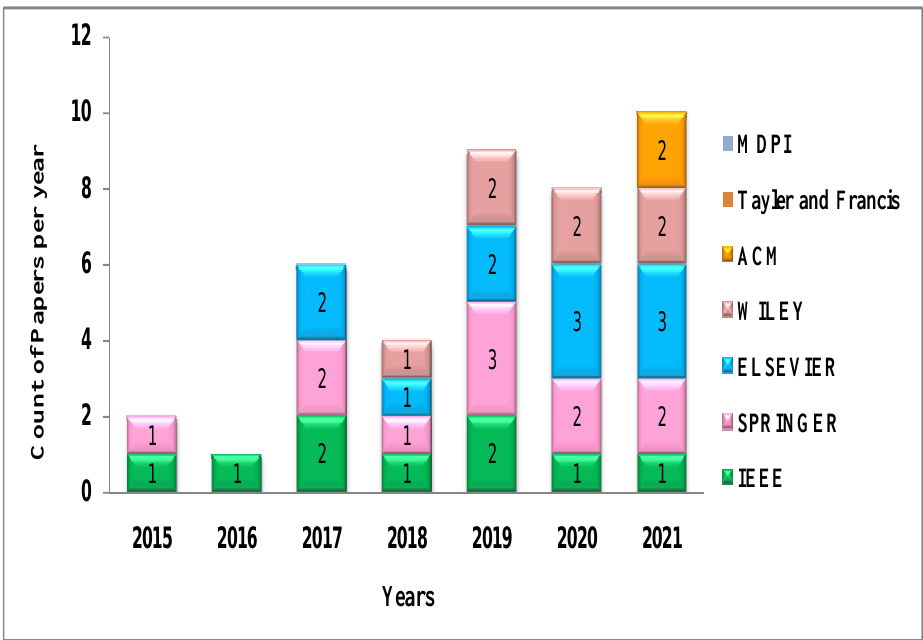
Figure 5. Number of papers per year grouped by publishers.